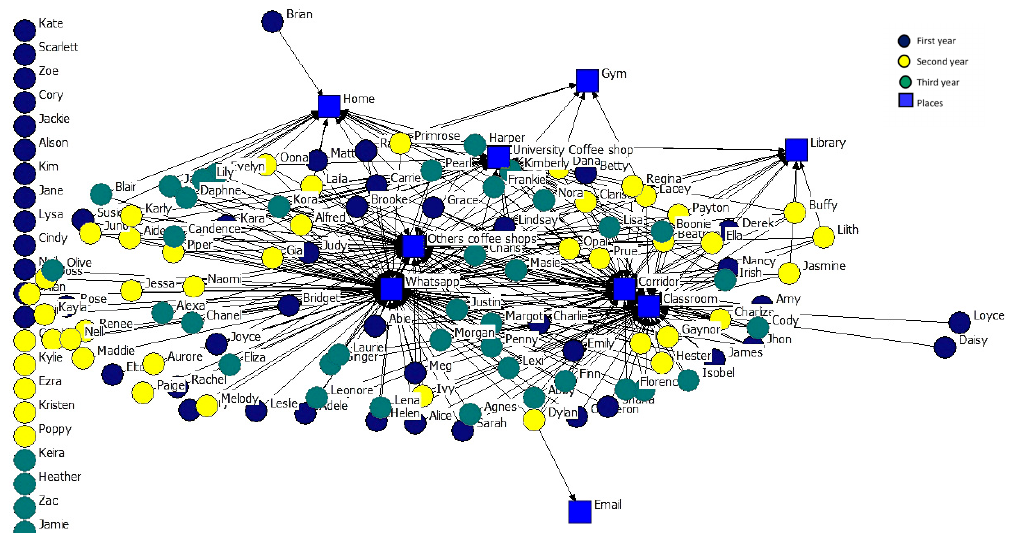
Figure 13. 2 ‐ mode Network of places where personal information is shared.